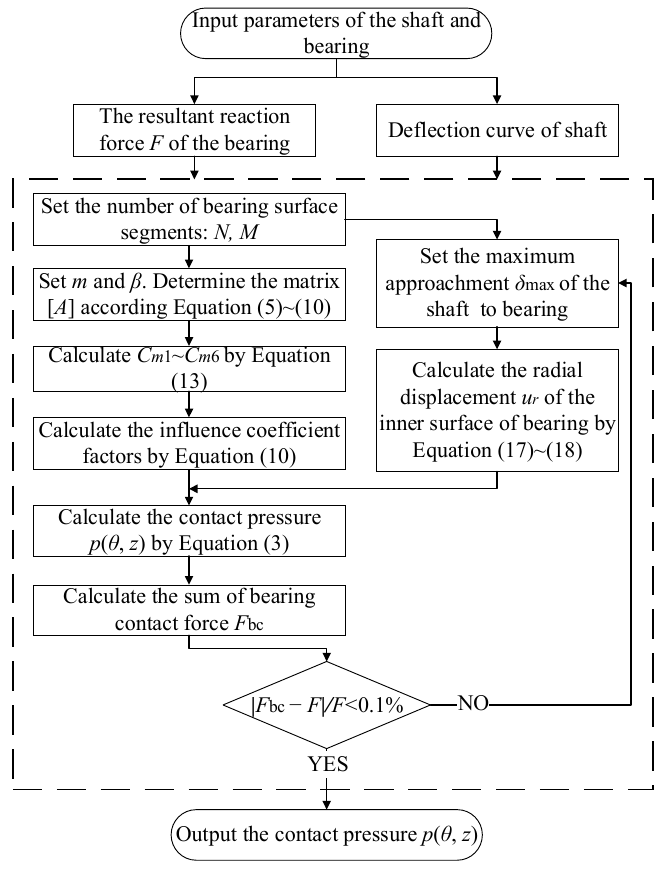
Figure 5. Flow chart of the numerical